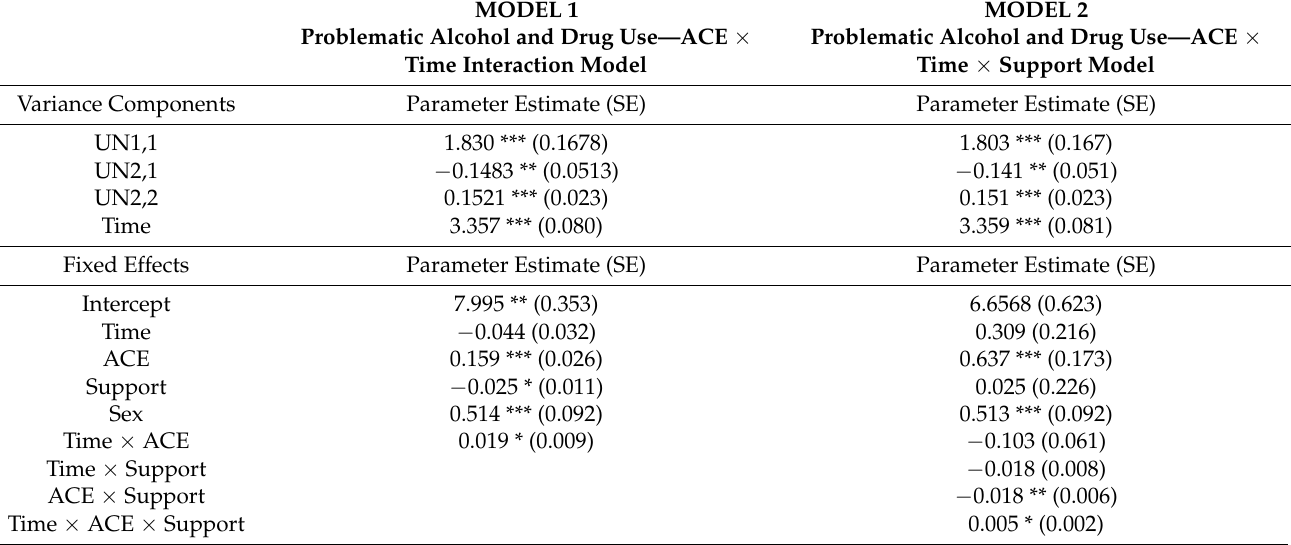
Table 2. Results of growth curve